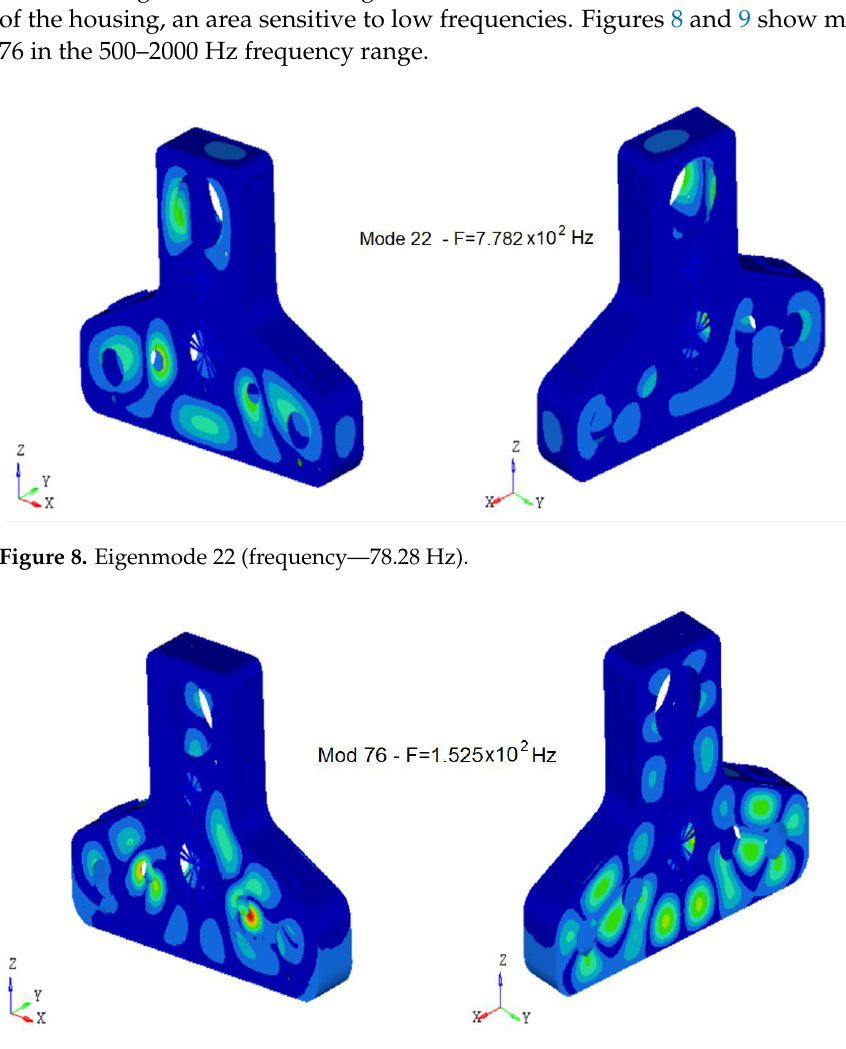
Figure 7. Eigenmode mode 7 (frequency — 379.89 Hz).